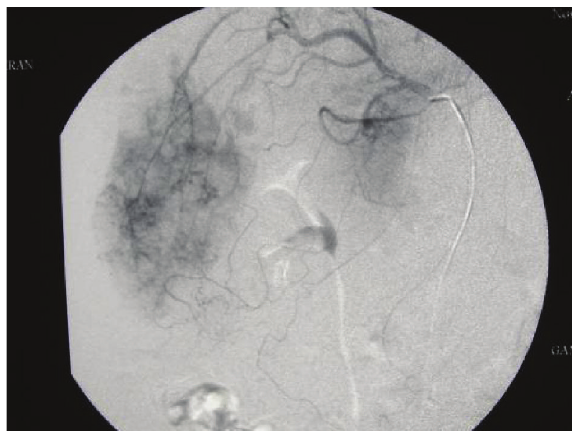
Figure 1: Selective right hepatic arteriogram demonstrating an ex- tensive vascular mass right lobe liver. No evidence of contrast ex- travasations to suggest acute hemorrhage at this time.